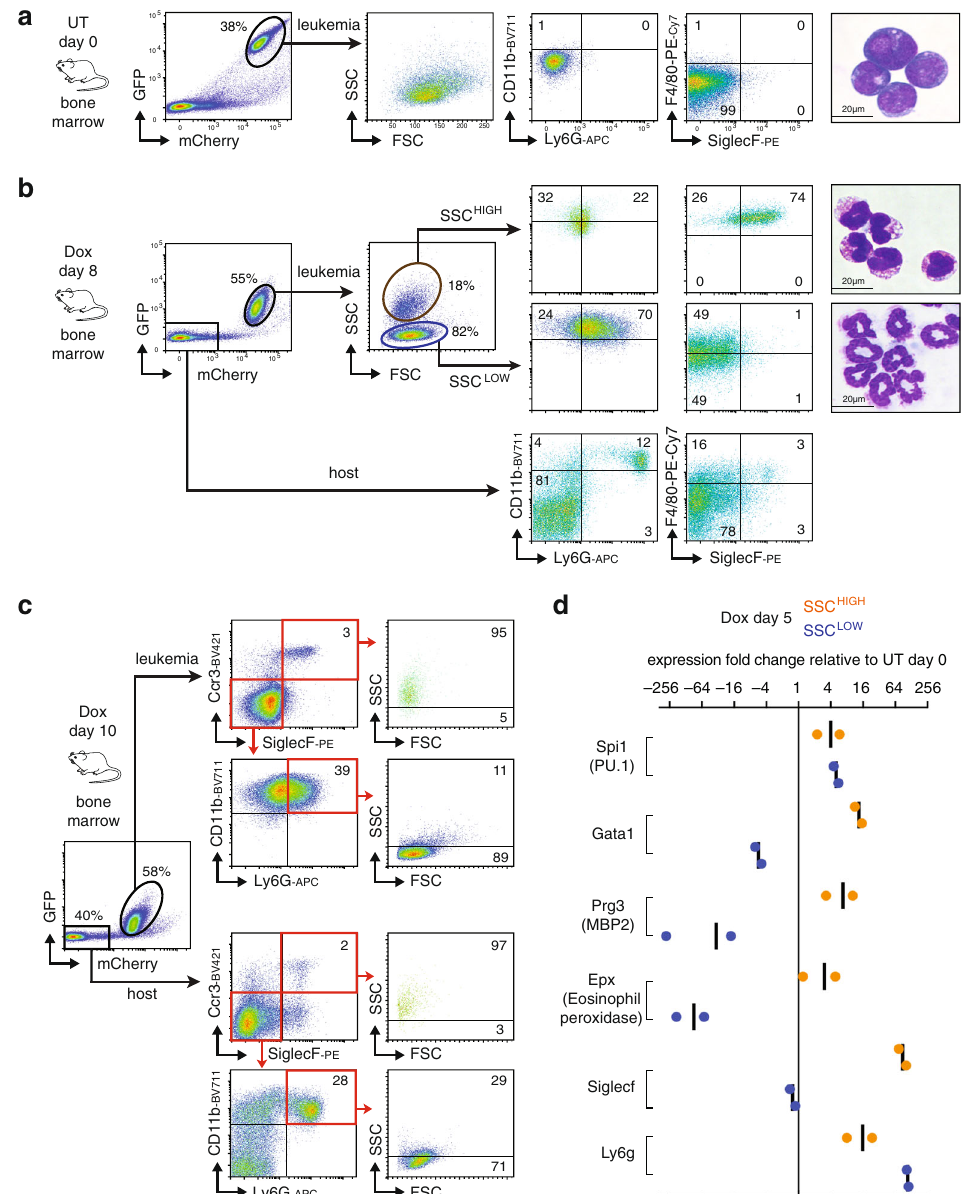
Fig. 2 AML differentiation bifurcates into distinct mature myeloid lineages. a , b Flow cytometry of bone marrow from mice with established AML246- Cherry leukemia either untreated ( a ) or Dox treated for 8 days ( b ) and harvested on the same day to allow matched fl ow cytometry gating analysis. Data are representative of three independent experiments with similar results. Matched cytospins are shown for sorted mCherry + cells from untreated mice and sorted mCherry + SSC HIGH or mCherry + SSC LOW AML-derived cells following 8 days Dox. c Immunophenotypic analysis comparing AML-derived (mCherry + ) and host (mCherry − ) cells within a representative AML246-Cherry leukemic mouse after 10 days Dox treatment. d mRNA expression by RT-qPCR of PU.1 and key neutrophil or eosinophil lineage genes in sorted mCherry + SSC HIGH and mCherry + SSC LOW AML-derived cells from 5 day Dox-treated mice, relative to mCherry + AML cells from untreated mice. Bars indicate the average of the two samples